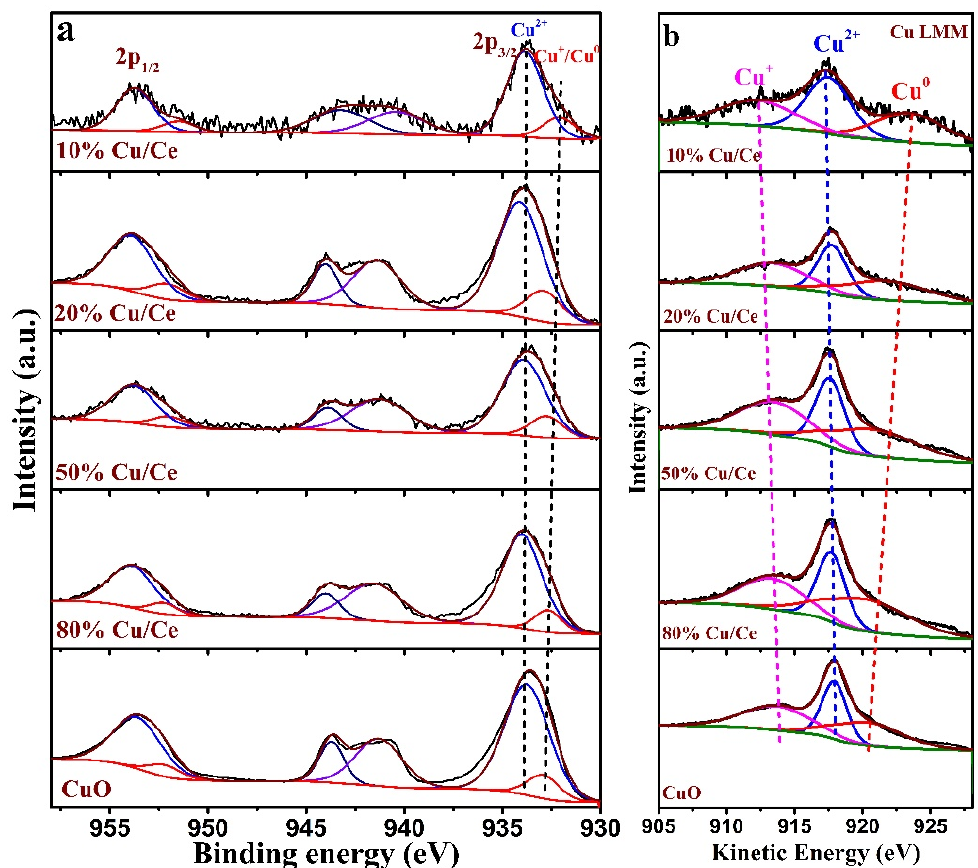
Figure 8. ( a ) Cu 2p XPS spectra and ( b ) Cu LMM spectra of the CuO/CeO 2 catalysts.